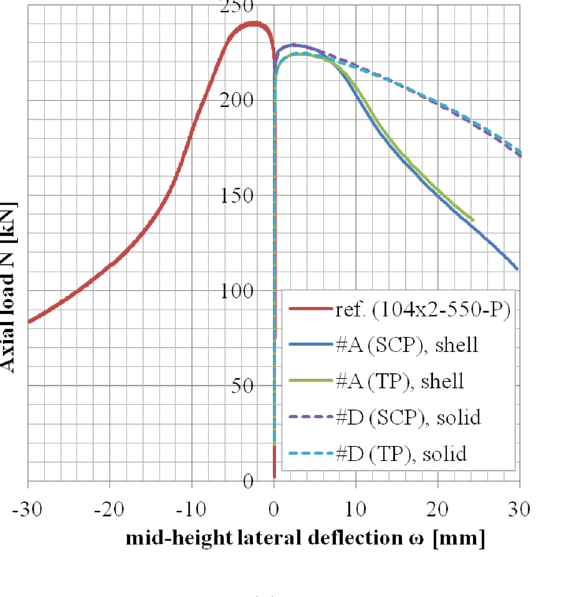
Figure 9. Experimental and FE load vs. midheight lateral deflection curves of 104 × 2-400-P [38]: ( a ) whole*; ( b ) zoomed.